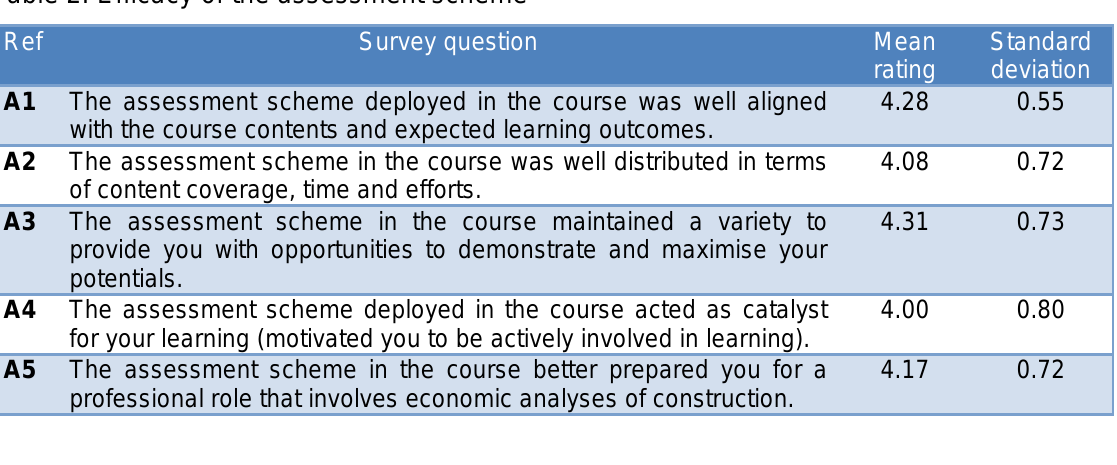
Table 2: Efficacy of the assessment scheme Ref Survey question Mean